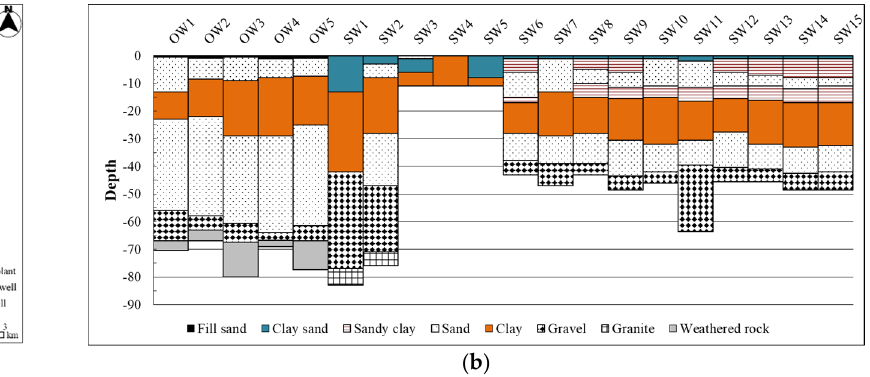
Figure 5. Boring test results of the observation and sampling wells in the Samrak Park, ( a ) location of wells, ( b ) well logs (modified from [21]).